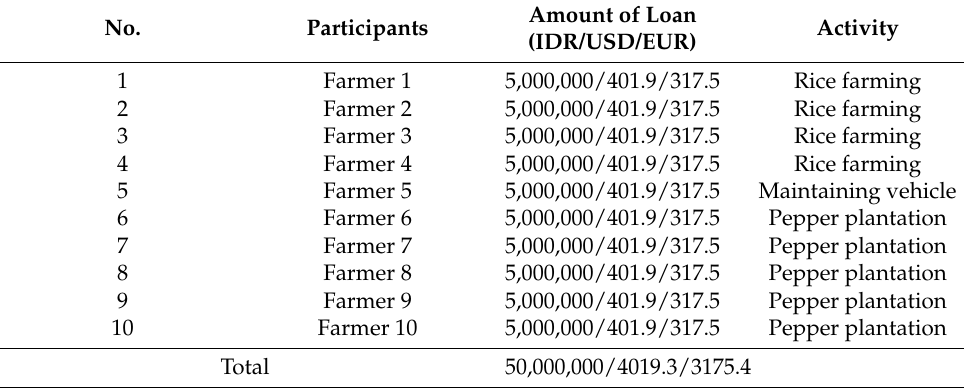
Table 5. Loan distribution among the Sumber Rejeki group 2014–2015 (2014 rates USD 1 = IDR 12,440 and EUR 1 = IDR